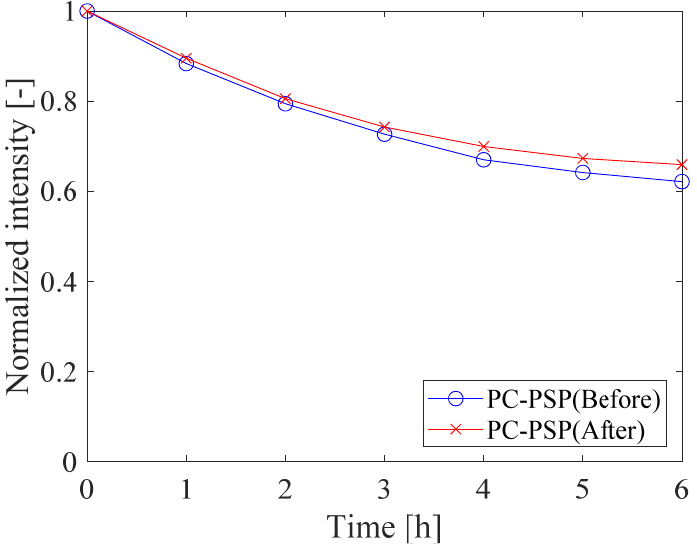
Figure 8. Thermal stability of PC-PSP before and after the heat treatment. The photostability of the PC-PSP after the heat treatment is shown in Figure 9. The pressure was set to 100 kPa and the temperature was set to 20 ◦ C and 100 ◦ C. The polymer- based PSPs were also evaluated for comparison. The results at 20 ◦ C show that the luminescence intensity of PC-PSP decreased to 0.90 after 1 h of continuous exposure to excitation light. On the other hand, no photodegradation is observed for the polymer-based PSP. At 100 ◦ C, the luminescence intensity of PC-PSP decreases to 0.04 after 1 h of excitation light illumination, while that of the polymer-based PSP is 0.49 after illumination. At 100 ◦ C, the photodegradation of the dye would be accelerated. In particular, the PC-PSP would be